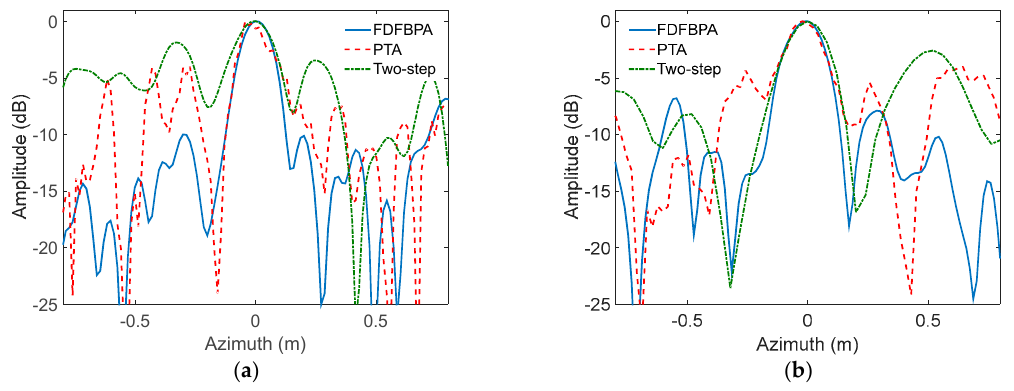
Figure 11. Comparison of four algorithms in Scene 1 and Scene 2: ( a ) Comparison of Scene 1 (left to right: FDFBPA, PTA and Two-step MOCO); ( b ) Comparison of Scene 2 (left to right: FDFBPA, PTA and Two-step MOCO).